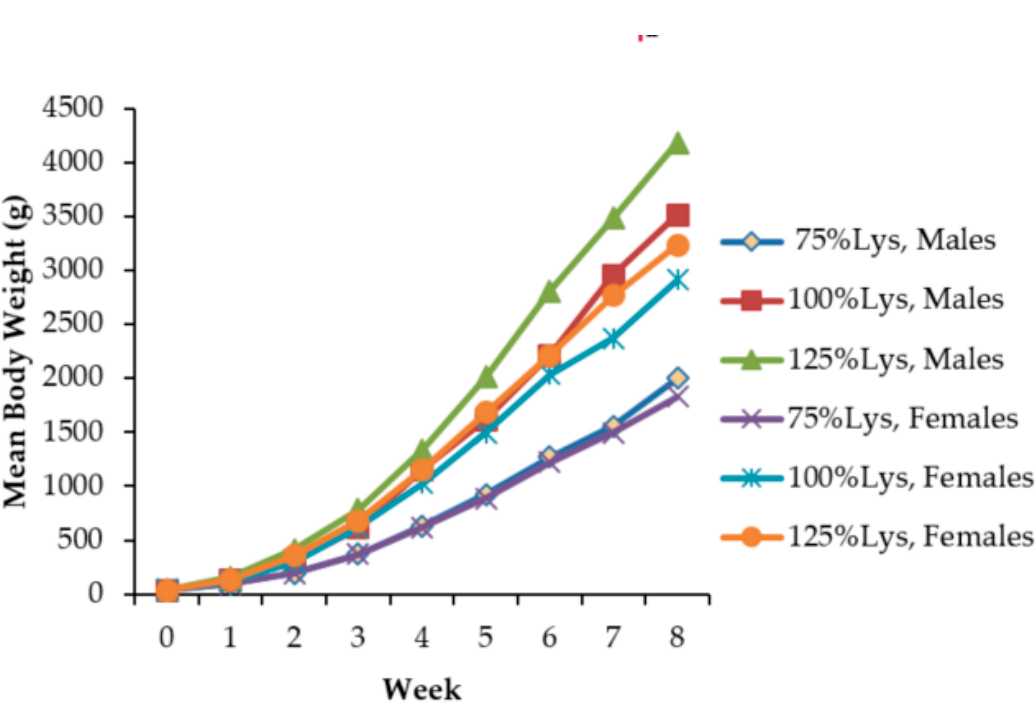
Figure 1. E ff ects of lysine on mean body weight. There is a significant increase in body weight with an increase in lysine concentration from week 1 to week 8. Male broilers had higher mean body weights on average than the female broilers in each ration. Lys: dietary lysine.